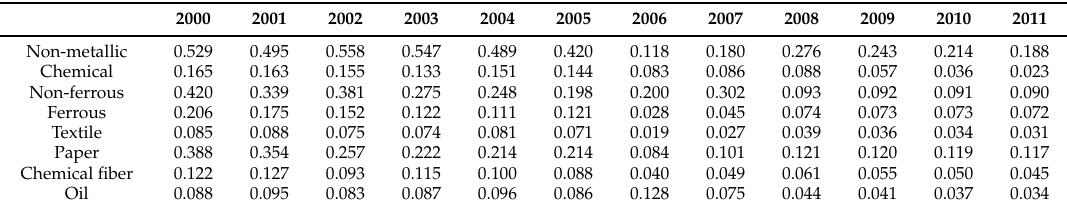
Table A1. Changes of SO 2 emission intensity ( e i ) in the seven industrial subsectors of Jiangsu province (unit: t/1000